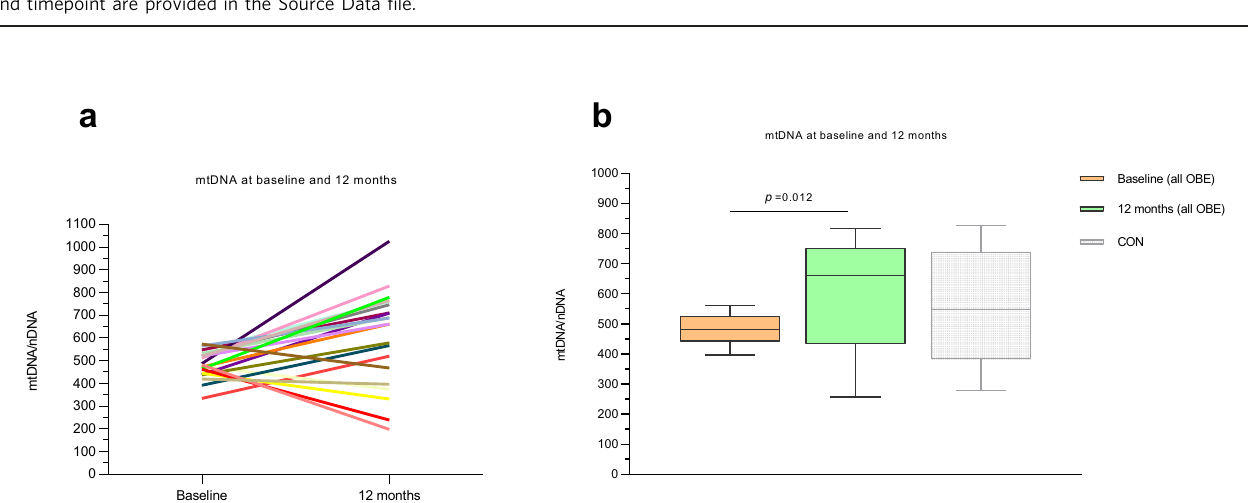
Fig. 5 Mitochondrial respiratory rates in liver tissue obtained from 21 patients with obesity during Roux-en-Y gastric bypass surgery or sleeve gastrectomy (baseline) and again by Tru-Cut percutaneous liver biopsy twelve months later. a Mass-speci fi c substrate-inhibitor protocol 1 (P1) fl uxes. b mass-speci fi c protocol 2 (P2) fl uxes; (GM fl uxes adjusted to mtDNA/nDNA. d P2 fl uxes adjusted to mtDNA/nDNA. e P/E D /GM). c P1 (OXPHOS max /FCCP). f Respiratory control ratio (RCR), (GM D /GM) This patient cohort consisted of NAFL + ( n = 6), NAFL − ( n = 13) and NASH ( n = 2) (based on their baseline liver biopsy). CONs (baseline) are also shown. No statistically signi fi cant differences were found between CONs and OBE 12 months after surgery. P1 and P2 were performed as described in Fig. 1 and Methods. Data are median (horizontal line), interquartile range (boxes) and 10 – 90% percentile (error bars). P -values (2-sided) are Wilcoxon-signed rank test. Orange boxes; OBE baseline, green boxes; OBE 12 months after surgery, grey boxes (dimmed); CON ( n < 10) at baseline. Source data are provided as a Source Data fi le. Speci fi c n ’ s in each protocol and for each substrate, group and timepoint are provided in the Source Data fi le.